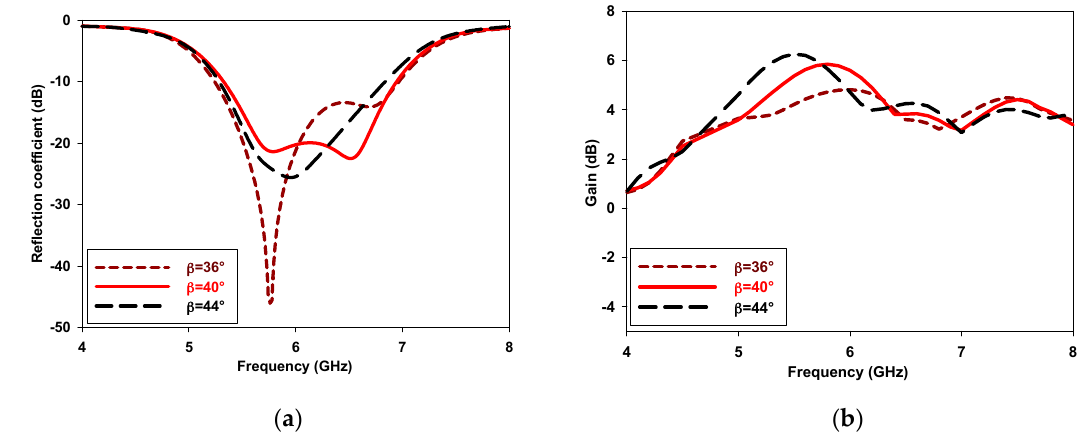
Figure 6. Simulated reflection coefficient and max gain versus the angle β : ( a ) Reflection coefficient, ( b ) Max gain.